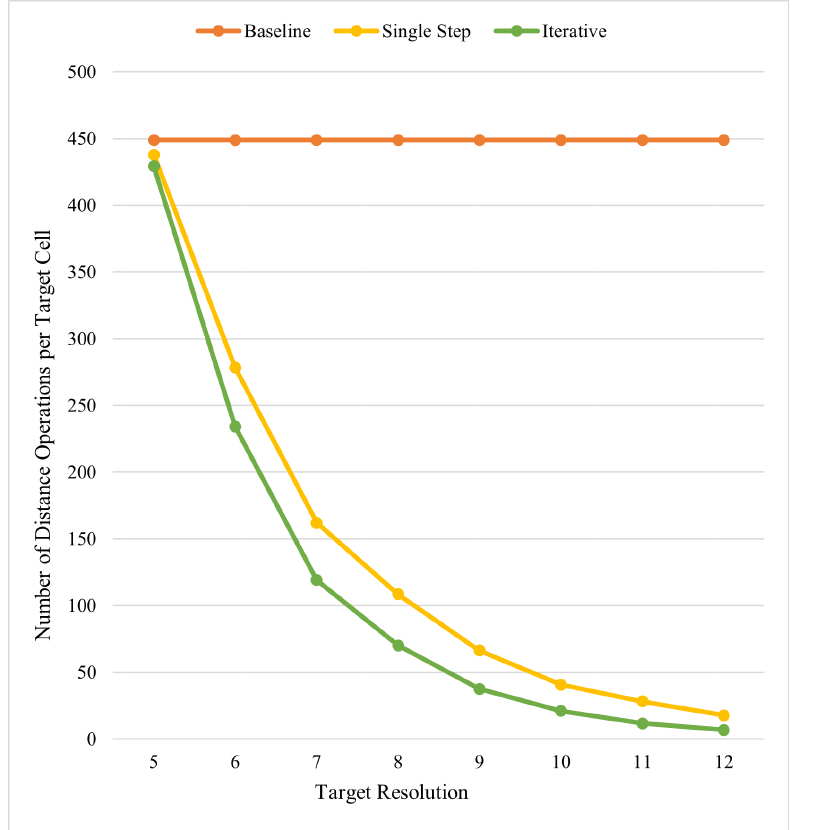
Figure 17. The number of distance operations in different target resolutions for the boundary of